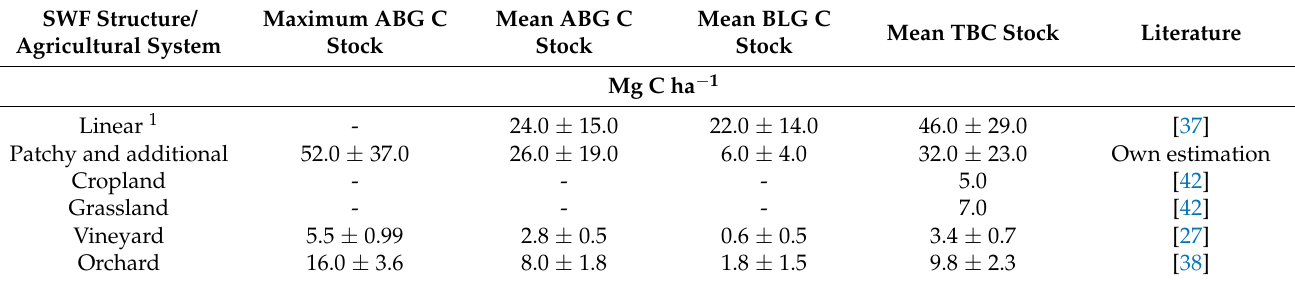
Table 1. Biomass carbon stock estimates (mean ± SD) established for SWFs and agricultural systems including cropland, grassland, and permanent crops (vineyards and orchards). ABG—above-ground, BLG—below-ground, TBC—total biomass